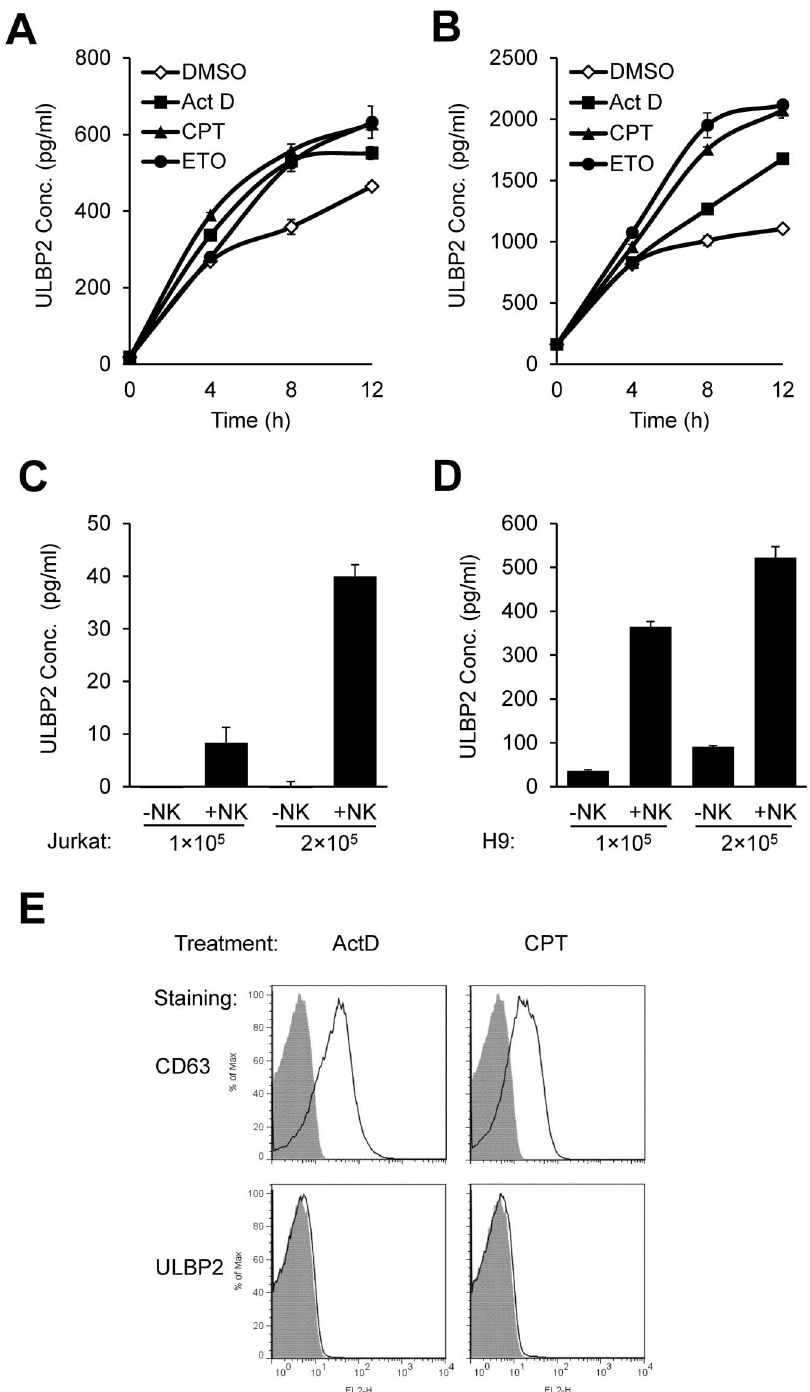
Figure 4. The spontaneous and NK cell-mediated shedding of ULBP2 from tumor cells. (A, B) Apoptosis-induced shedding of ULBP2 is more intense than spontaneous shedding of it. (A) 2.5 6 10 6 Jurkat cells were treated with 2 m g/ml ActD, 4 m M CPT or 20 m M ETO for the indicated time in 0.5 ml serum-free RPMI 1640 medium. (B) 5 6 10 5 cells H9 were treated with 2 m g/ml Act D, 4 m M CPT or 50 m M ETO for the indicated time in 0.5 ml serum-free RPMI 1640 medium. The supernatant was collected for ELISA assay. DMSO was used as a negative control. (C, D) NK cell-induced shedding of ULBP2. 1 6 10 5 IL-2 expanded human NK cells were co-cultured with the indicated number of Jurkat (C) or H9 cells (D) for 2 hours, and then culture media were collected for ULBP2 ELISA. (E) Absence of ULBP2 in exosomes. 2 6 10 7 H9 cells were resuspended in 10 ml serum-free RPMI 1640 medium and treated with ActD or CPT overnight. Exosome preparations from the resulting culture supernatants were used to coat 4- m m- diameter aldehyde/sulfate latex beads by passive adsorption. The coated beads were used for detection of CD63 and ULBP2 by flow cytometric analysis. Beads with exosomes coating are showed in solid lines, and beads without exosomes coating are showed in gray-shaded histograms as controls.